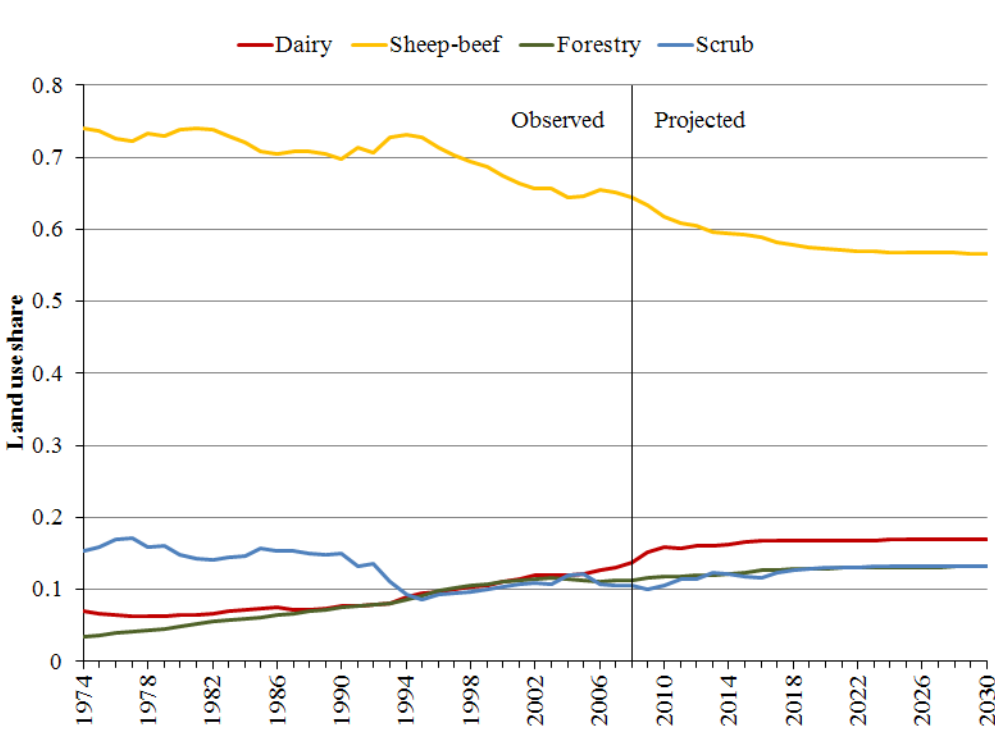
Figure 1. Baseline national-level land-use share projections, 2009–2030. Details on the projections are in the